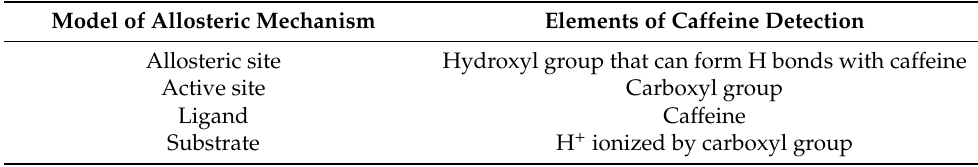
Table 3. Elements of the allosteric mechanism and caffeine detection.